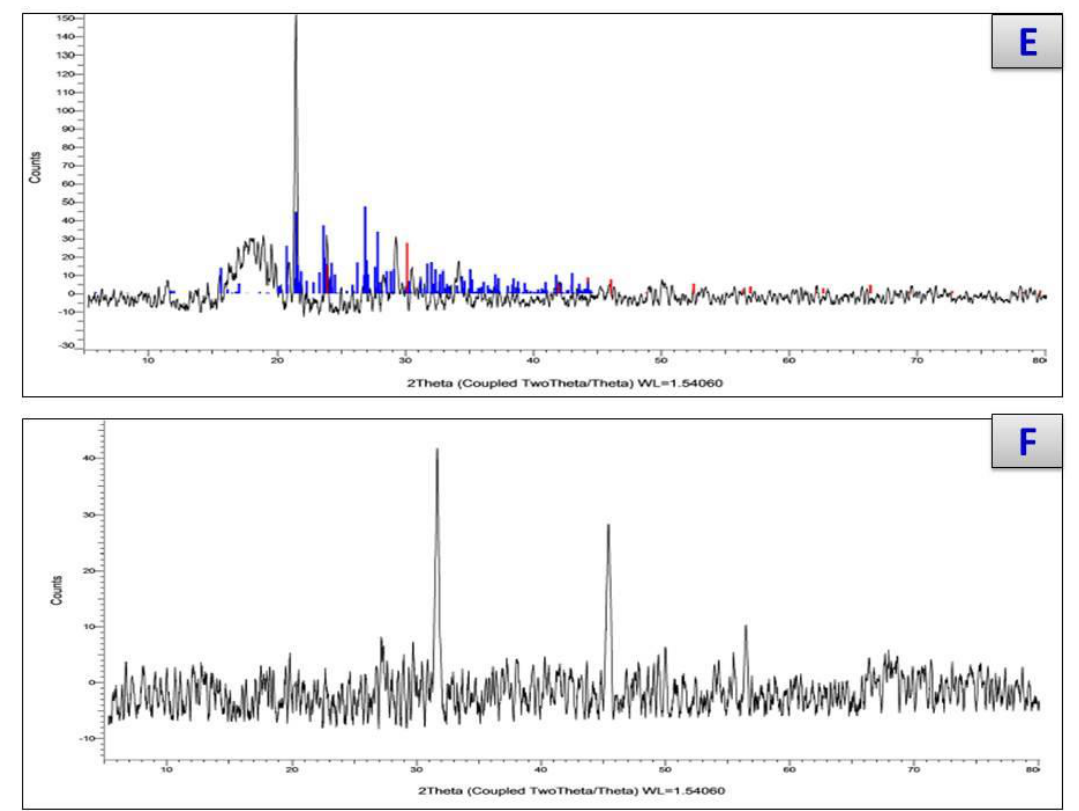
Figure 5. XRDs of ( A ) Cfotax, ( B ) cefotax/Ca, ( C ) cefotax/Cu, ( D ) cefotax/Zn, ( E ) cefotax/Se, and ( F ) cefotax/Cr.